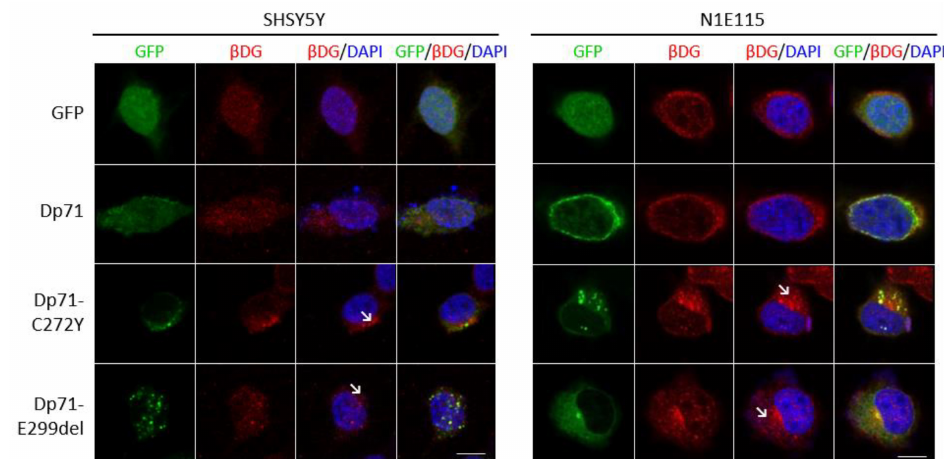
Figure 4. Neuronal cells expressing Dp71-C272Y and Dp71-E299del show the altered localization of β -DG. SH-SY5Y and N1E-115 cells transiently expressing GFP, GFP-Dp71, Dp71-C272Y or Dp71- E299del were immunostained for β -DG and counterstained with DAPI to visualize nuclei, prior to being imaged by CLSM. Representative optical Z-sections are shown (scale bar = 10 µ m). The polarized distribution of β -DG with aggregates is denoted by